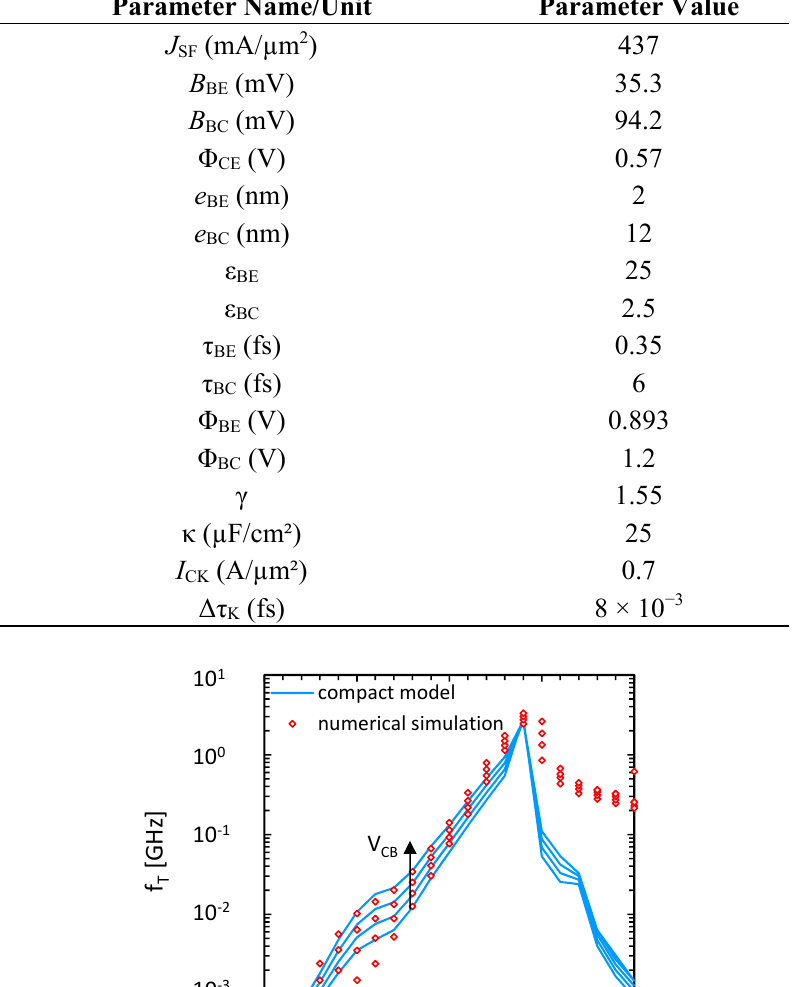
Table 1. Parameters used in the compact model simulation.